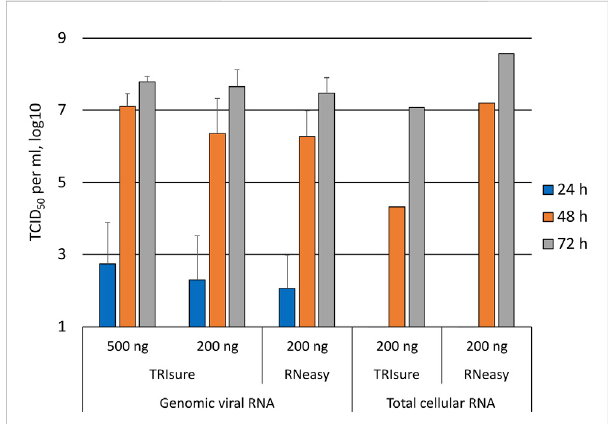
FIGURE 3 Daily follow-up of the appearance of infectious viruses into media post-transfection. Supernatant samples were collected daily from transfected wells and analyzed with an endpoint dilution assay for the presence of infectious viruses. The fi gure presents the TCID 50 /ml results from daily samples only from wells in which infectious viruses were observed at 72 h timepoint. The means and standard errors of the means have been calculated from the following numberofexperiments(thetotalnumber ofreplicatesinparenthesis): 500 ng TRIsure, 1 (3); 200 ng TRIsure, 3 (13); 200 ng RNeasy, 4 (14). Theresults fortotalcellularRNAtransfection arefromasinglepositive well for both TRIsure and RNeasy extracted RNA. TRIsure, RNA extracted with TRIsure reagent; RNeasy, RNA extracted with RNeasy Mini